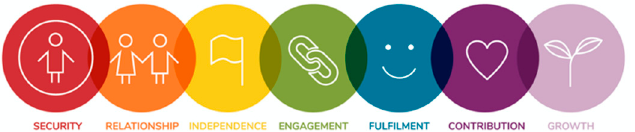
Figure 2. Flourish Project—The Seven Core Human Needs/Motivations.